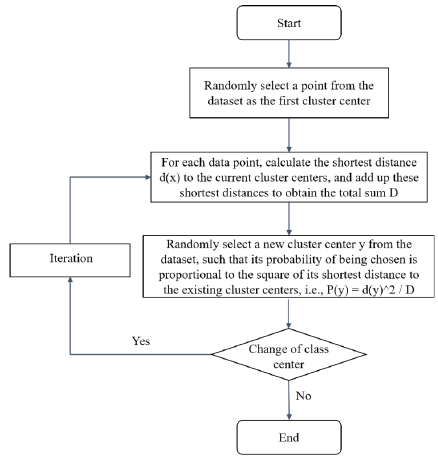
Figure 5. K-means++ algorithm flow chart.